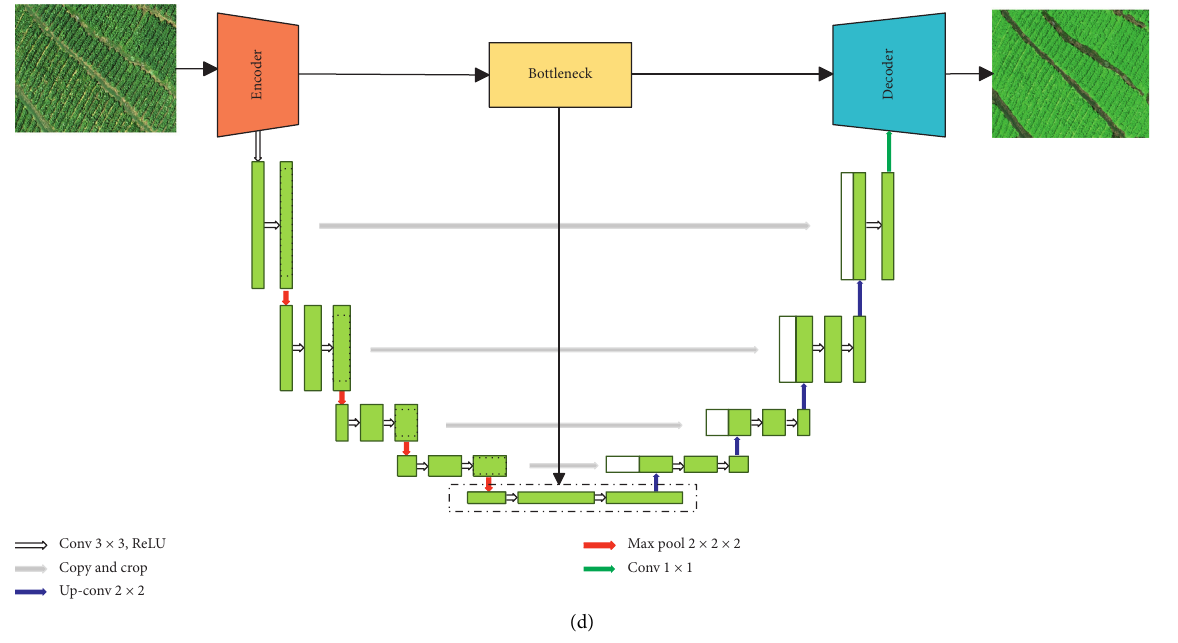
Figure 6: Four kinds of deep learning network structure. (a) DeeplabV3+. (b) PSPNet. (c) SegNet. (d) U-Net. Table 1: Time efficiency and accuracy under different values of three parameters.